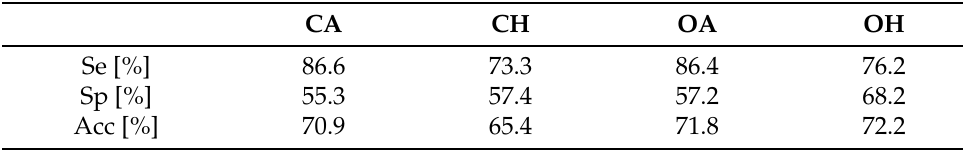
Table 5. Apnea and hypopnea detection